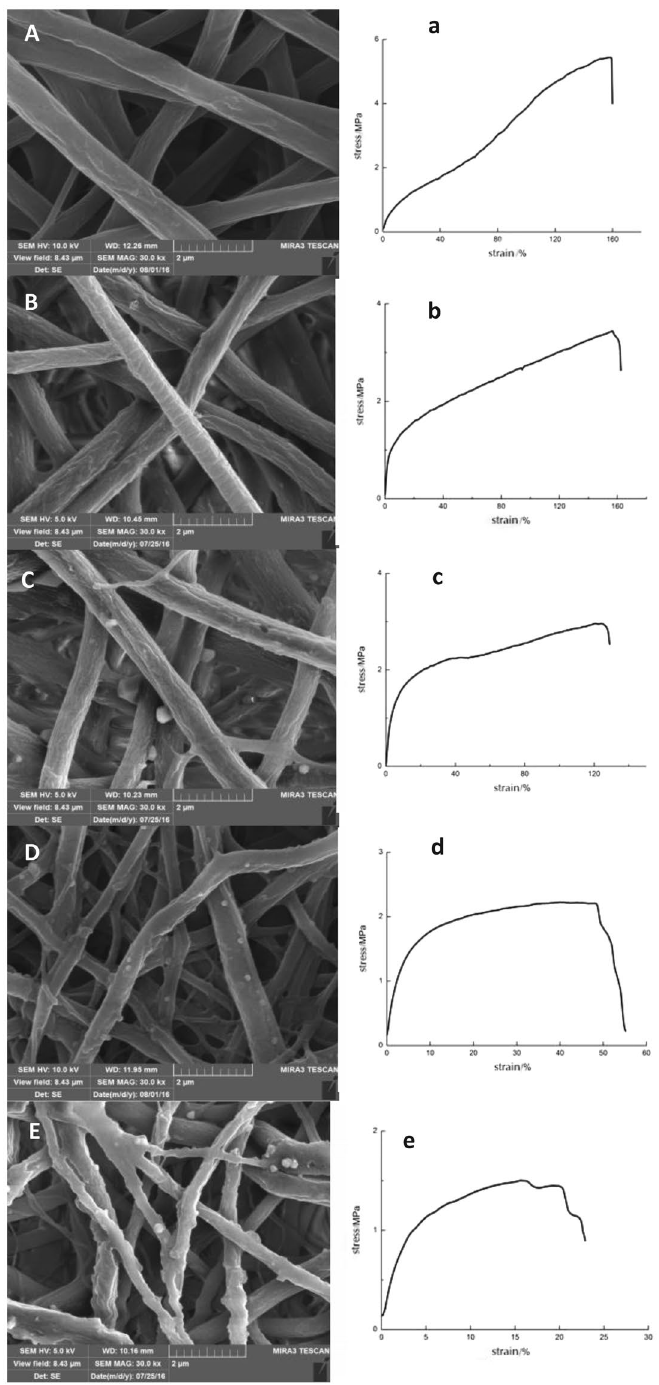
Figure 4. Morphological changes and tensile strength tests of the core–shell structured nanofibrous membrane during PBS immersion. Membranes were incubated for 0 weeks ( A , a), 1 week ( B , b), 2 weeks ( C , c), 4 weeks ( D , d), and 6 weeks ( E ,